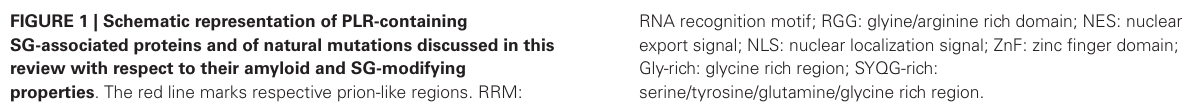
RNA recognition motif; RGG: glyine/arginine rich domain; NES: nuclear export signal; NLS: nuclear localization signal; ZnF: zinc finger domain; Gly-rich: glycine rich region; SYQG-rich: serine/tyrosine/glutamine/glycine rich